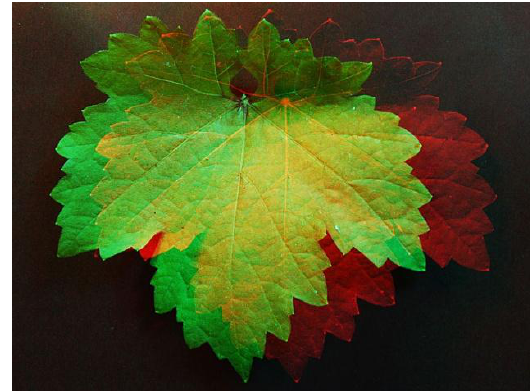
Figure 13. Anaglyph of the leaf of autochthonous vine For what concerns elaboration with the Agisoft software, a spread cloud of 115756 points, once the outliers have been eliminated, has produced a dense cloud of 34853 points, 11507 of which have been tie points (Engels et al., 2006). The vector mesh, represented in Figure 14, has a planimetric precision of the order of thousandths of millimeter and inferior to the millimeter for the third dimension,